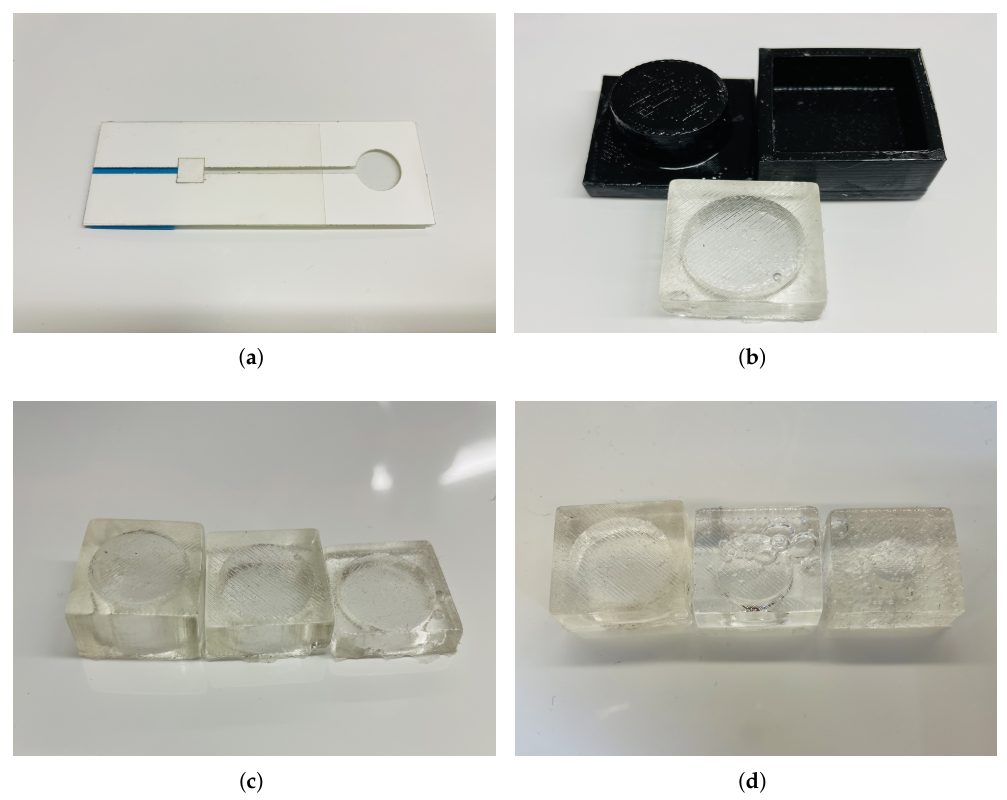
Figure 2. ( a ) Fabricated and assembled microfluidic device; ( b ) 3D-printed PDMS mold with acrylic coating and PDMS micropump; ( c ) Three different PDMS micropumps of 1 cm, 0.7 cm, and 0.4 cm heights with the same 2 cm diameter; ( d ) Three different PDMS micropumps with 2 cm, 1.5 cm, and 0.5 cm diameters with the same 0.7 cm